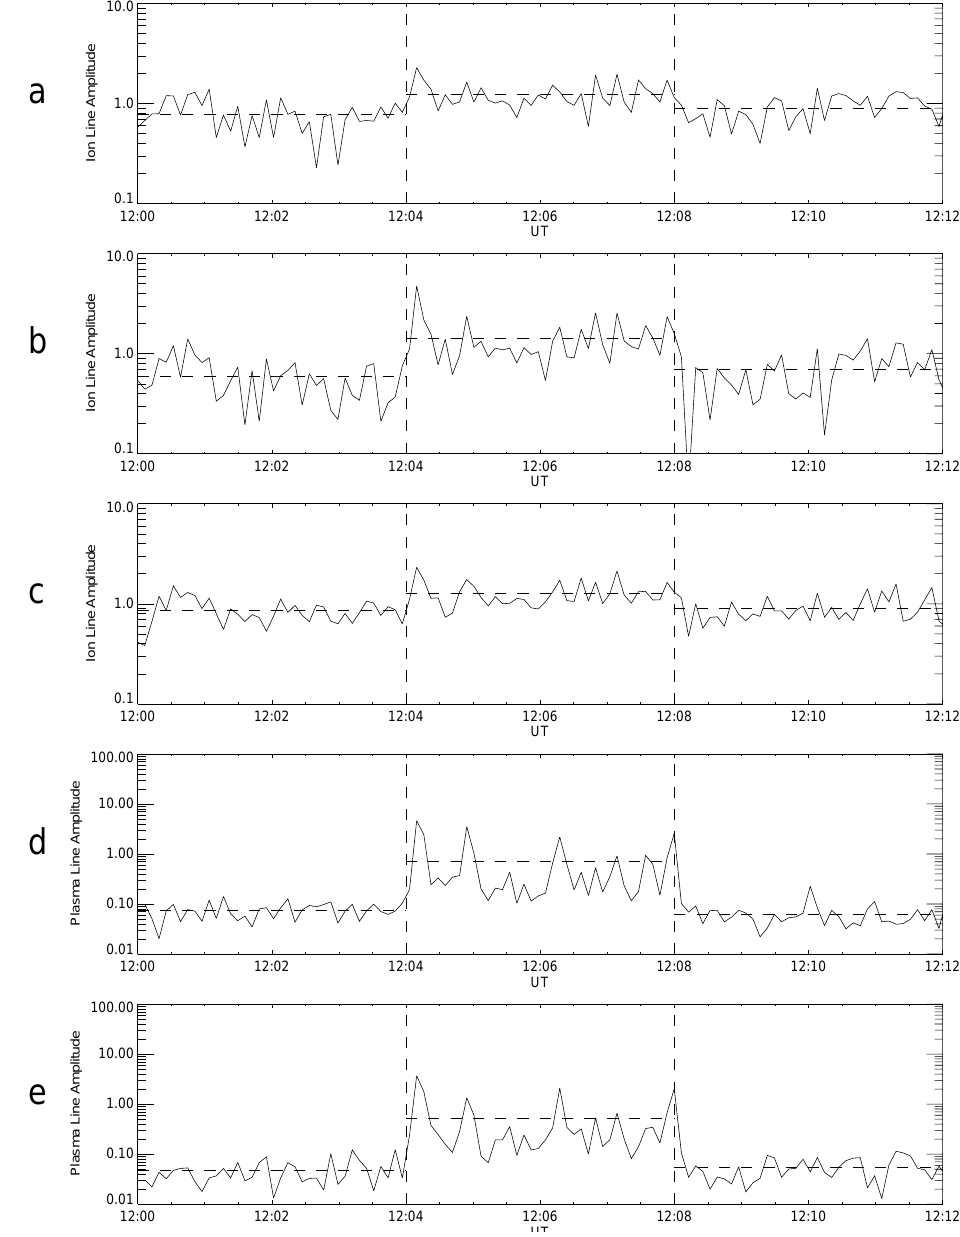
Fig 9 Fig. 9. Time series of amplitudes of ESR ion- and plasma-lines for 12:00–12:12 UT, 27 April 2004. Panel (a) contains the upshifted ion-line; (b) , the unshifted ion-line centre frequency; (c) , the down shifted ion-line; (d) , the upshifted plasma-line and (e) , the downshifted plasma-line.